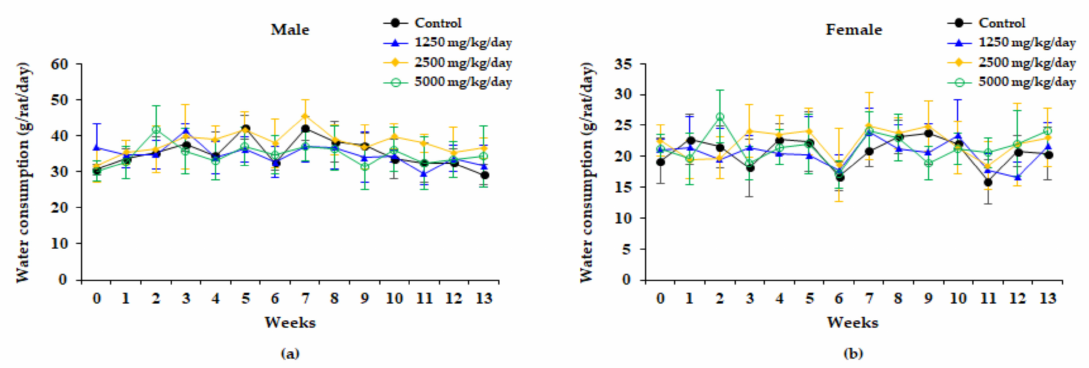
Figure 3. Water consumption of male ( a ) and female ( b ) rats treated with 0, 1250, 2500, and 5000 mg/kg/day in the 13 weeks repeated oral dose toxicity study of WG extract. Results are presented as the mean ± standard deviation (n = 10).